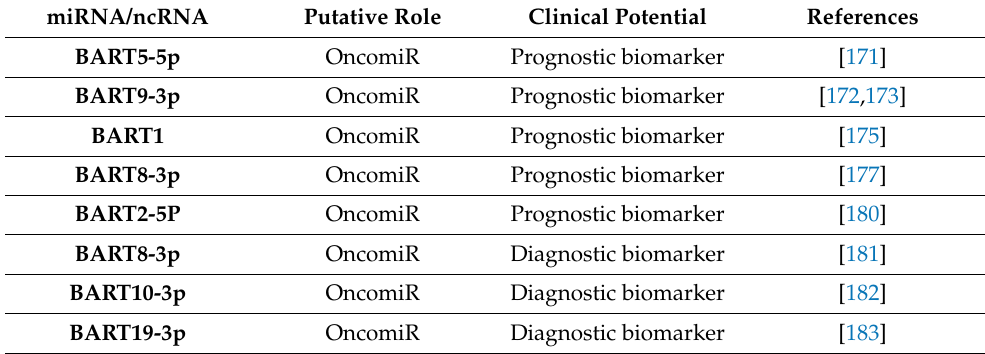
Table 4. EBV-encoded miRNAs in